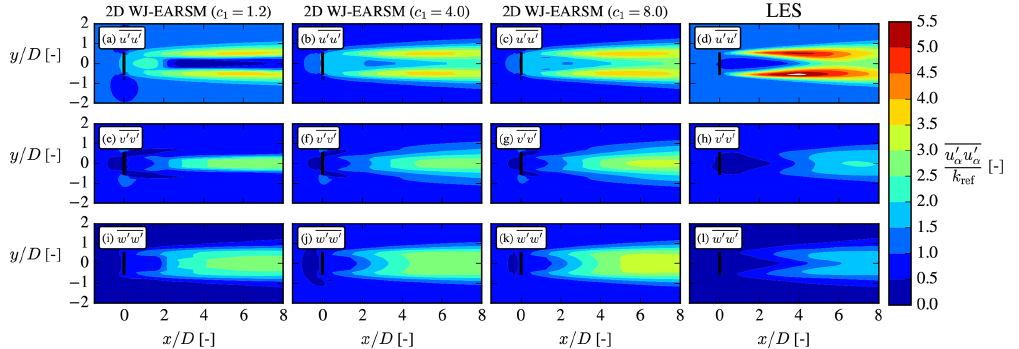
Figure B3. Normal stresses at hub height for the single-wake V80 case with different sets of model